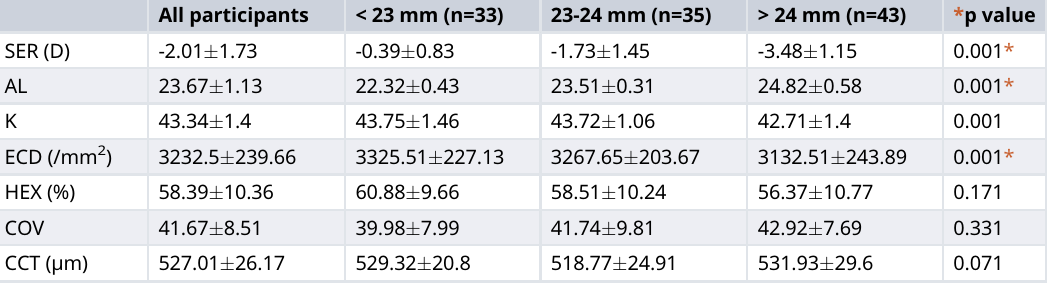
Table 3. CEC parameters (ECD, HEX, COV, and CCT) between different AL groups.